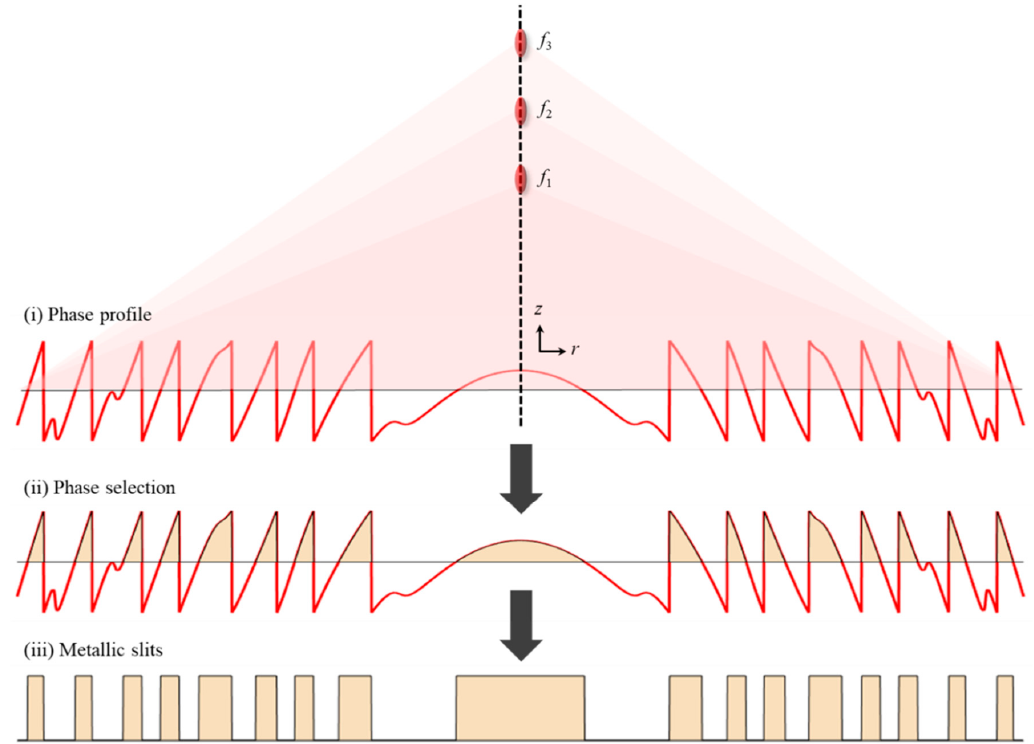
Figure 1. Design principle for a multi-focal MFZP: (i) Generation of a phase profile from the VPSs placed at different focal points. (ii) Application of the PSR, selectively taking the sections where constructive interferences take place. (iii) Creation of an on–off (open–closed) metallic slit pattern based on the binary quantization of the phase profile.